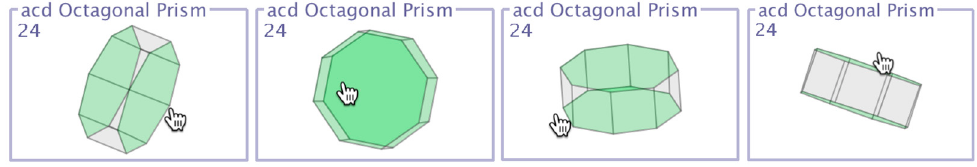
Figure 9. The filter controls for 3D cells are interactive, allowing users to rotate the cells and view them from different angles directly within the detail pane. These four images are snapshots of a user interacting with the octagonal prism from Figure 8.